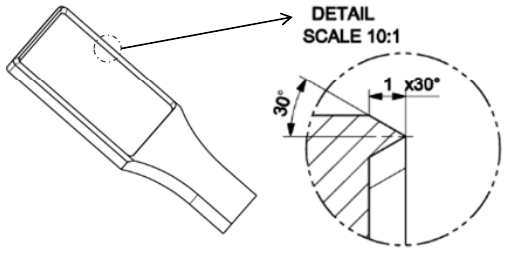
Figure 4. Geometry option A.